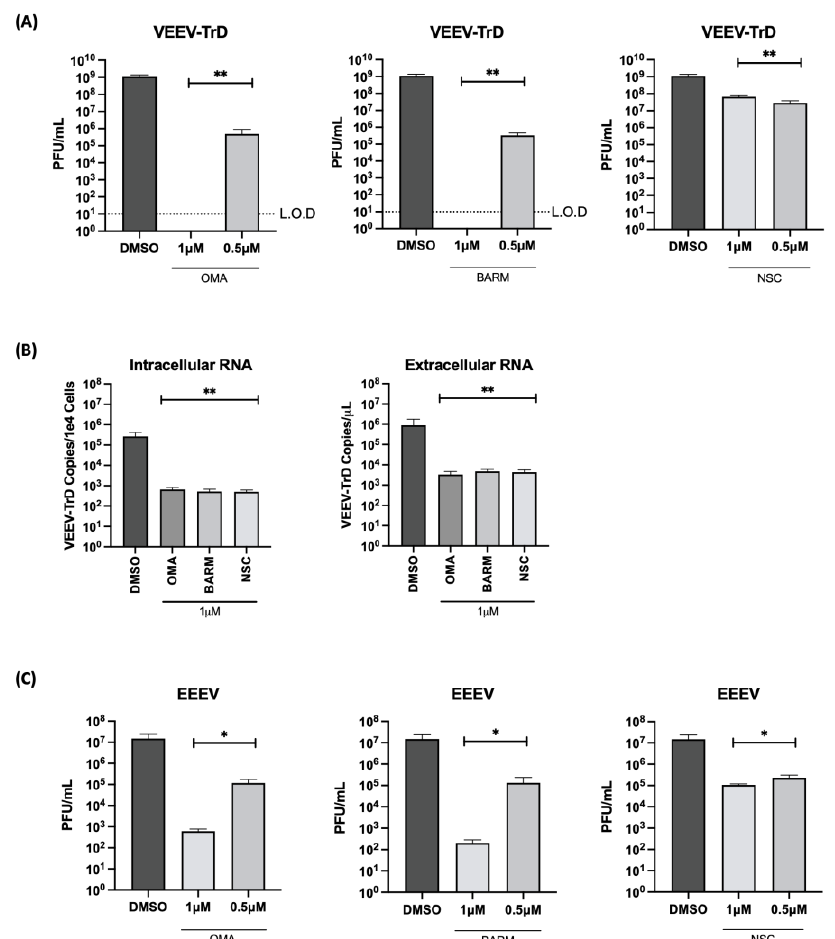
Figure 7. OMA, BARM and NSC demonstrate broad-spectrum inhibition of virulent strains of VEEV and EEEV. HMC3 cells were seeded in a 96-well plate and pre-treated for 1 h with inhibitors (0.5 µM) or DMSO, followed by an infection with VEEV-TrD or EEEV FL93 (MOI: 0.1). After infection, the cells were post-treated with the inhibitors or with DMSO-containing medium. ( A , C ) Culture supernatants were collected at 18 h post-infection and assessed by plaque assay. ( B ) RNA was isolated from VEEV-TrD-infected HMC3 cells for qRT-PCR analysis. Cells were lysed for intracellular RNA isolation and supernatant was collected for extracellular RNA. The viral genomic copy number for VEEV-TrD in the extracted RNA was quantified by qRT-PCR for intracellular RNA and extracellular (supernatant) viral RNA quantification, data reported as genomic copies per cell (intracellular) or per µ L (extracellular). Infectious titer for each virus is reported as plaque-forming units (PFU) per mL. Limit of detection (L.O.D) is included for panel A. Statistical analysis determined using One-way ANOVA with Dunnett’s post-test. * p < 0.05, ** p <